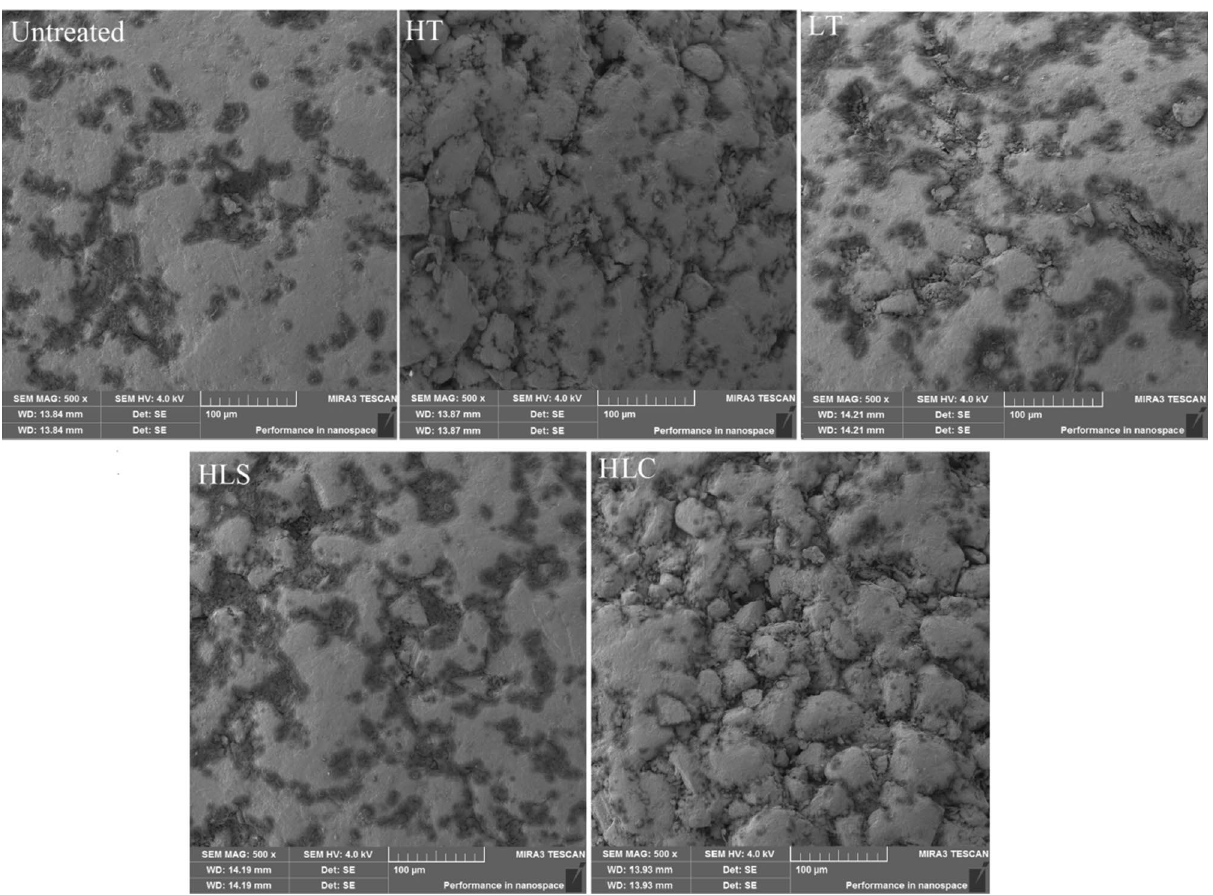
Figure 3. Surface morphology of the HNIW/FOX-based PBX modeling